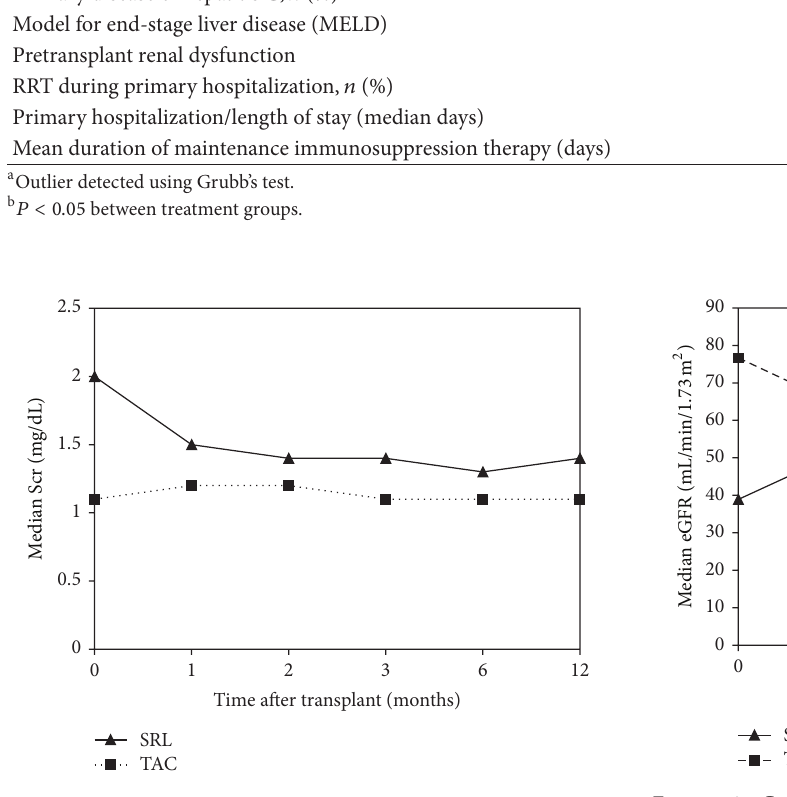
Figure 1: Comparison of mean serum creatinine between SRL ( 𝑛 = 29 ) and TAC ( 𝑛 = 168 ) groups over 1-year follow-up after transplant ( 𝑃 < 0.05 at all time points).